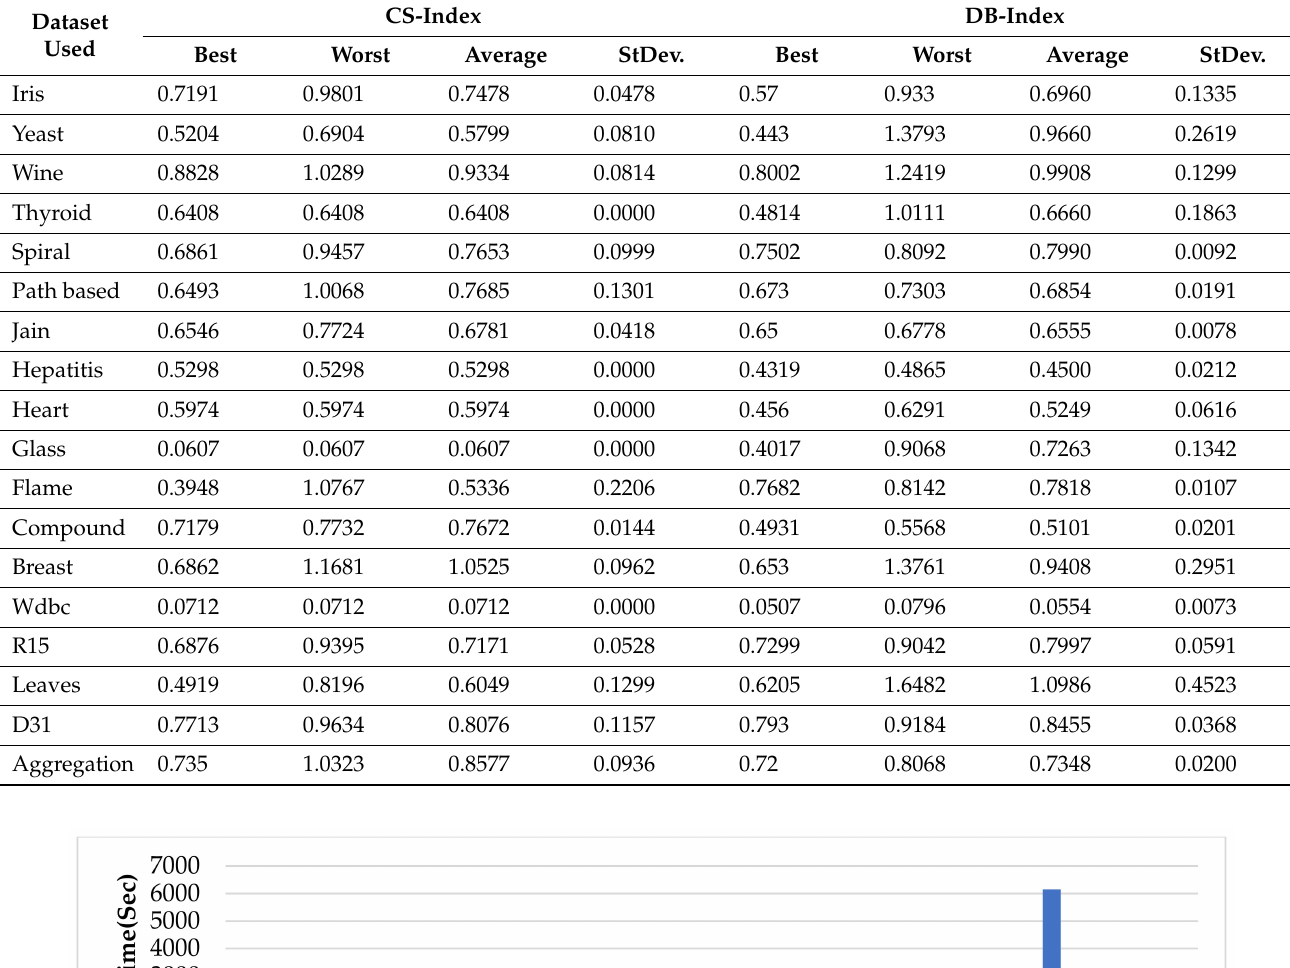
Table 4. Numerical results of HCFAPSO based on CS and DB validity indices over 20 independent runs.